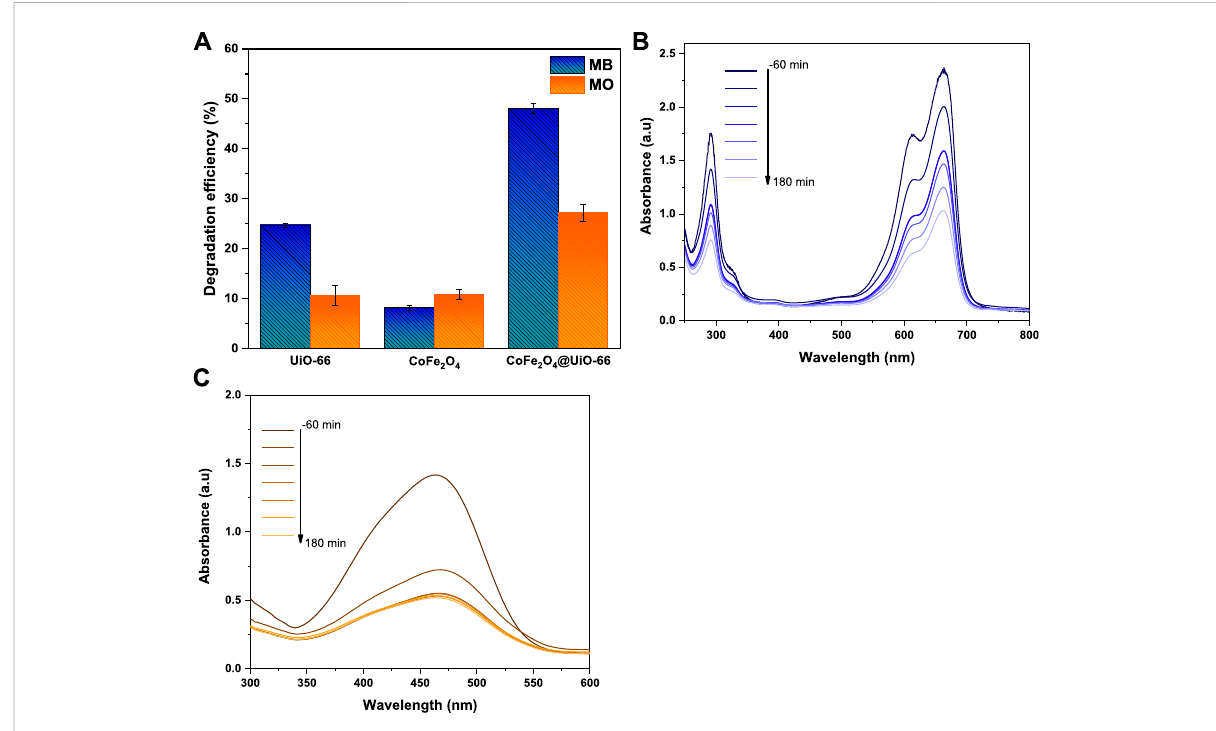
FIGURE 12 The photodegradation ef fi ciency of as-synthesized photocatalysts (A) , UV-Vis absorption spectra for degradation of MB (B) and MO (C) dyes over